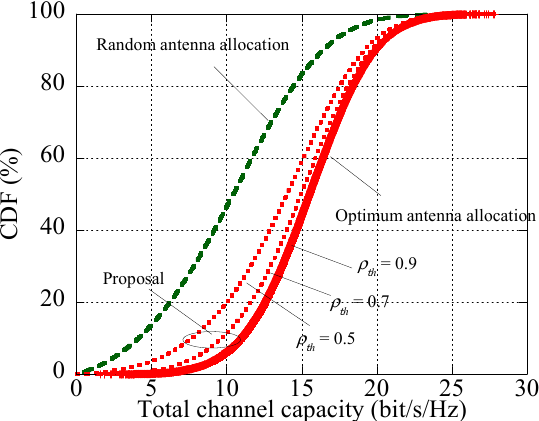
Figure 7. CDF of the total channel capacities of the downlink MU-MIMO-OFDM transmission with the proposal and random/optimum antenna allocations.